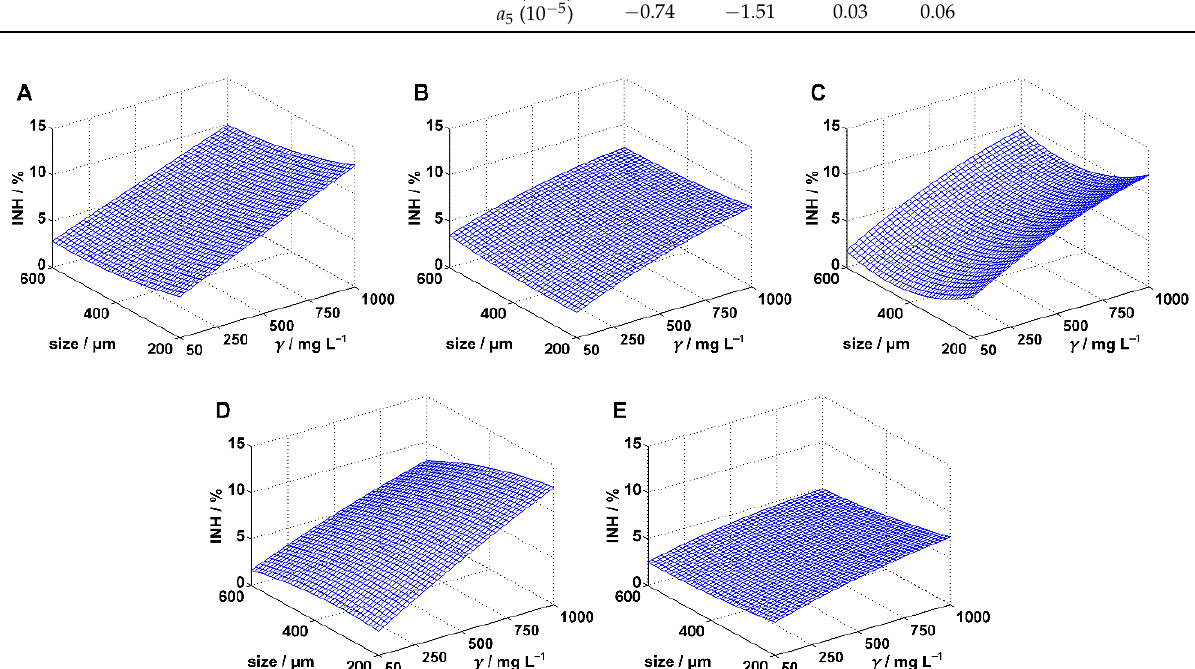
Figure 1. Inhibition surfaces estimated for Scenedesmus sp. by the best regression models. The cases are: ( A ) polyethylene, ( B ) polypropylene, ( C ) polystyrene, ( D ) polyvinyl chloride, and ( E ) polyethylene terephthalate. Table 2. Statistical analysis of the regression models (Equations (3)–(5)) for the microalgae Scenedes- mus sp. The microalgae were exposed to microplastics (MPs) particles of: polyethylene (PE), poly- propylene (PP), polystyrene (PS), polyvinyl chloride (PVC), and polyethylene terephthalate (PET). The analyzed factors were concentration and size of the particles.